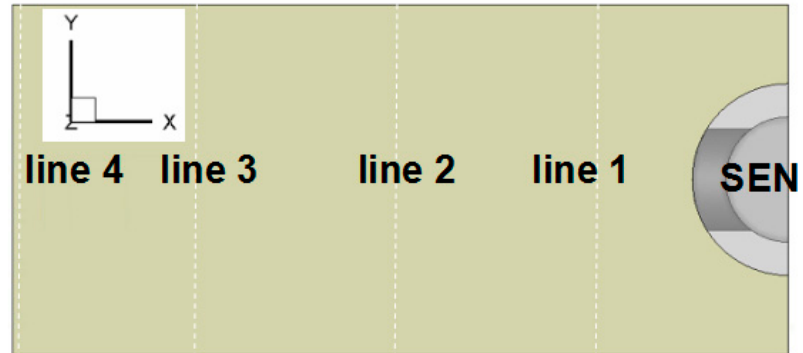
Figure 11. Locations of four monitored lines.